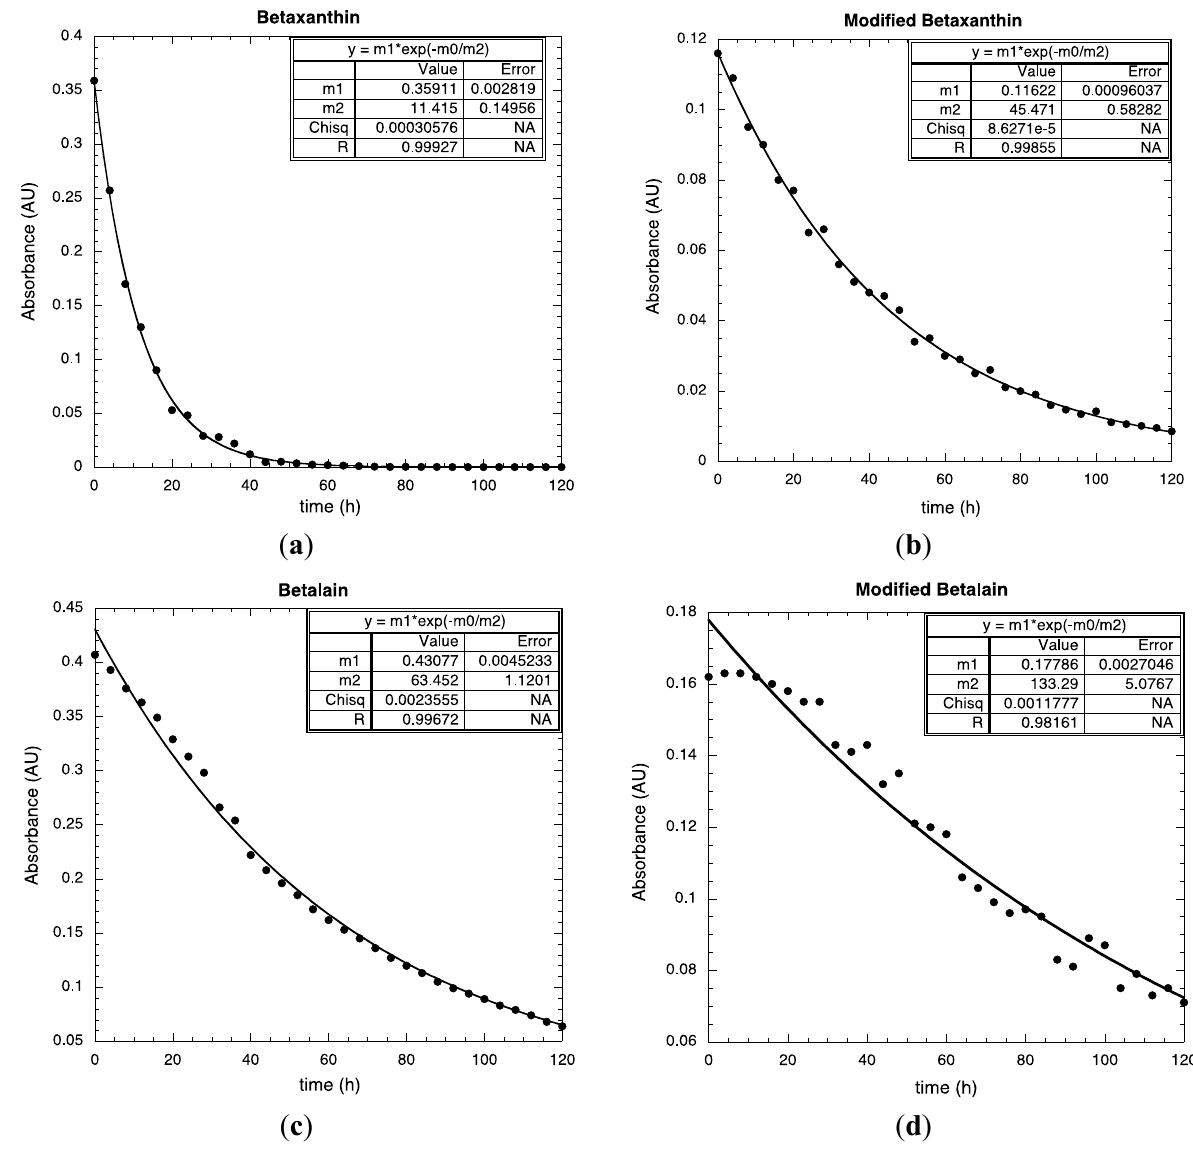
Figure 7. Absorbance versus Time for ( a ) BVE at 482 nm, ( b ) BVE/TEOS at 482 nm, ( c ) BVE at 535 nm and ( d ) BVE/TEOS at 535